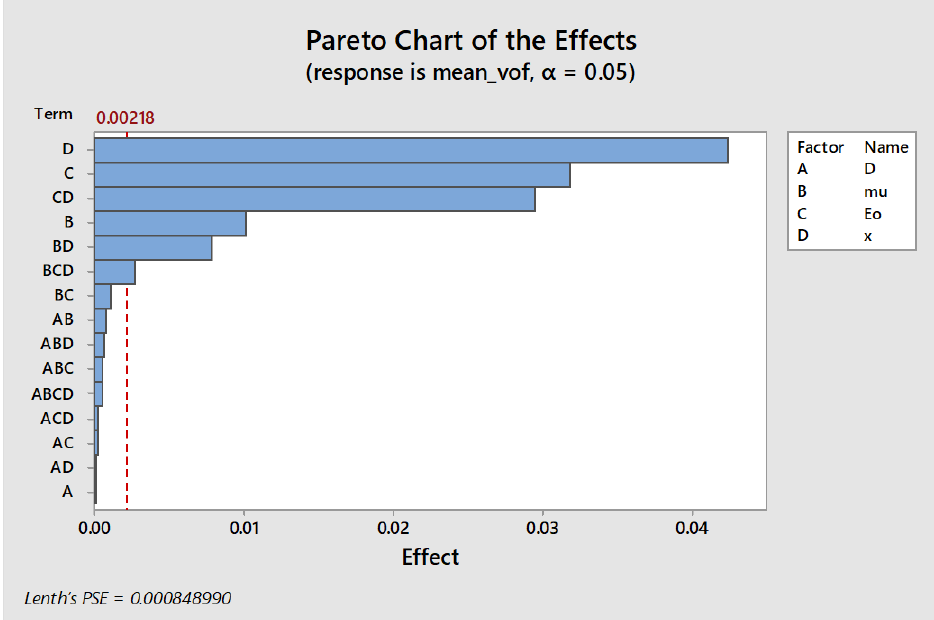
Figure 9. Pareto chart of the single effects, namely pressure drop at the inlet valve (droplet size, D), content of freshwater x, temperature (viscosity of the oil µ), and electric field E. In addition, effects of double, triple, and quadruple interactions are shown.